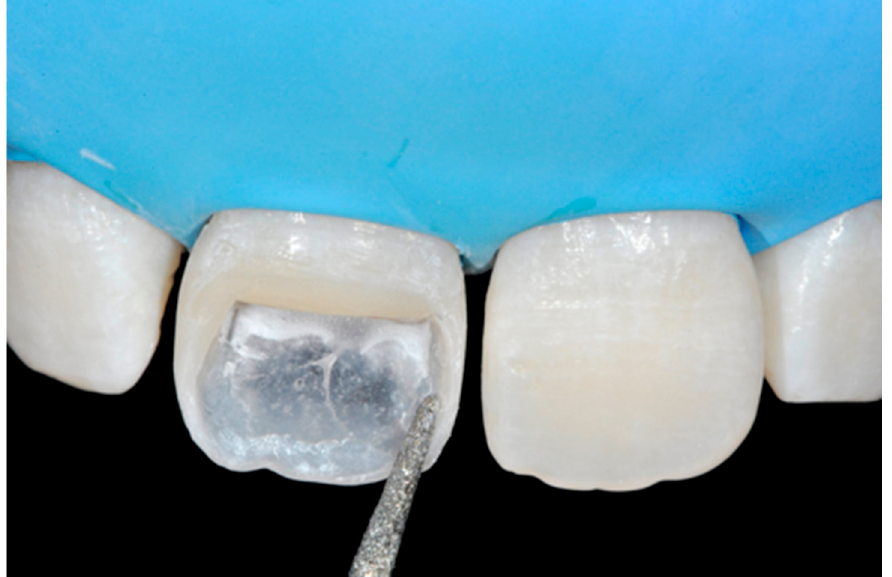
Figure 8. Excessive thickness of interproximal walls is reduced with a low-speed diamond bur. Reprinted from Restauri diretti nei settori anteriori, G. Paolone, S. Scolavino, © 2021, with permission from Quintessence Publishing Italy.